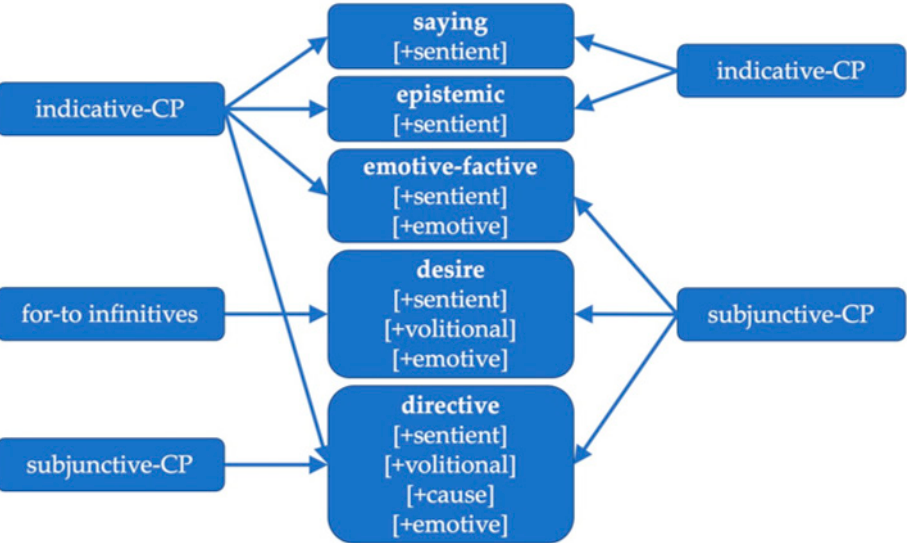
Figure 3. Mapping of the semantic features of verbs selecting tensed CPs (middle column) onto corresponding forms in English (left column) and French (right column). corresponding forms in English (left column) and French (right